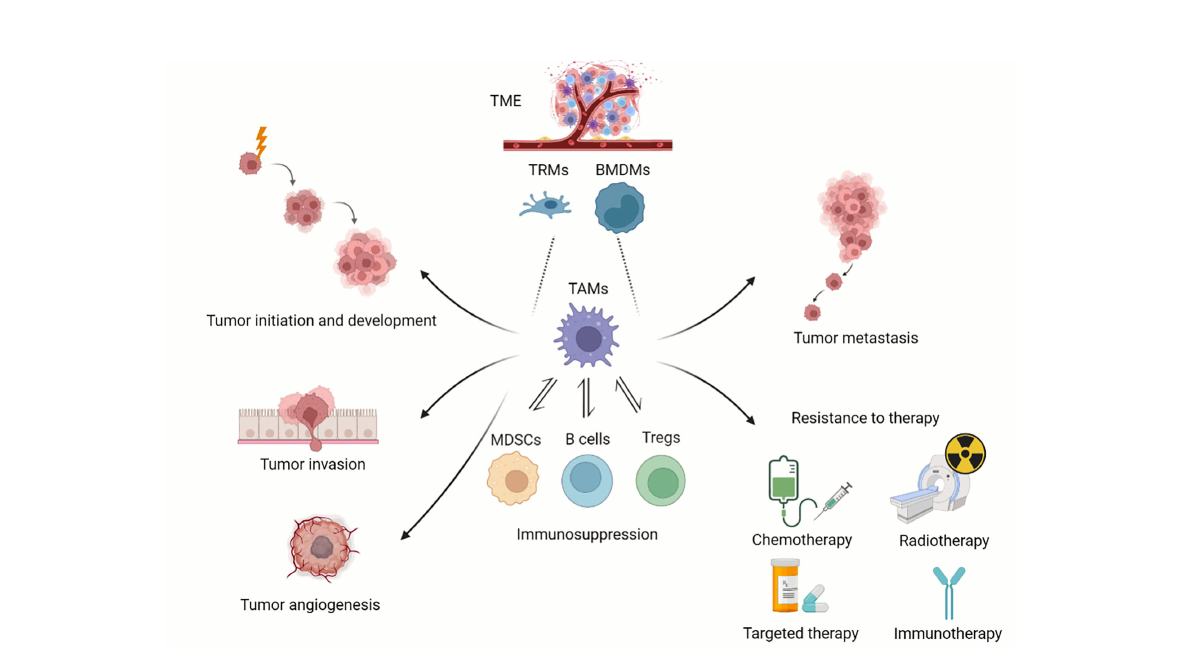
FIGURE 1 Roles of TAMs in tumor progression. Overview of TAMs in tumor progression. TAMs can derive from BMDMs and TRMs. TAMs provide a niche for tumor initiation and development, participate in angiogenesis, promote tumor metastasis, and enhance resistance to chemotherapy, radiotherapy and immunotherapy. (Created with